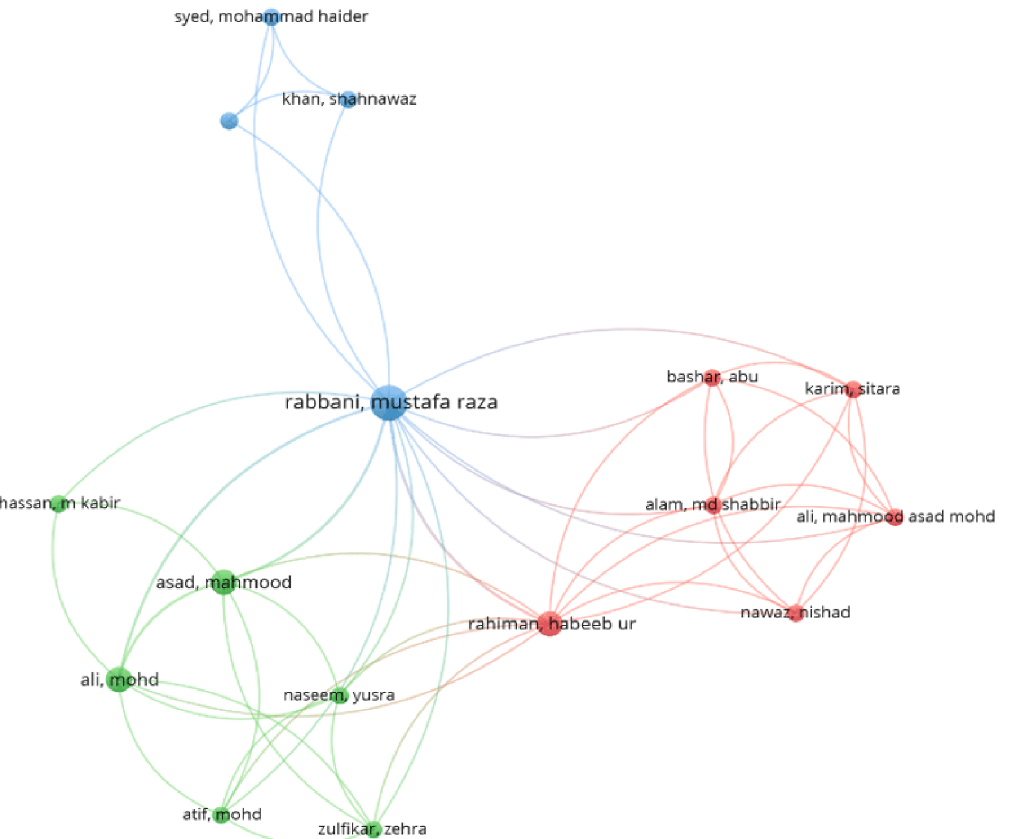
Figure 6. The collaboration network of